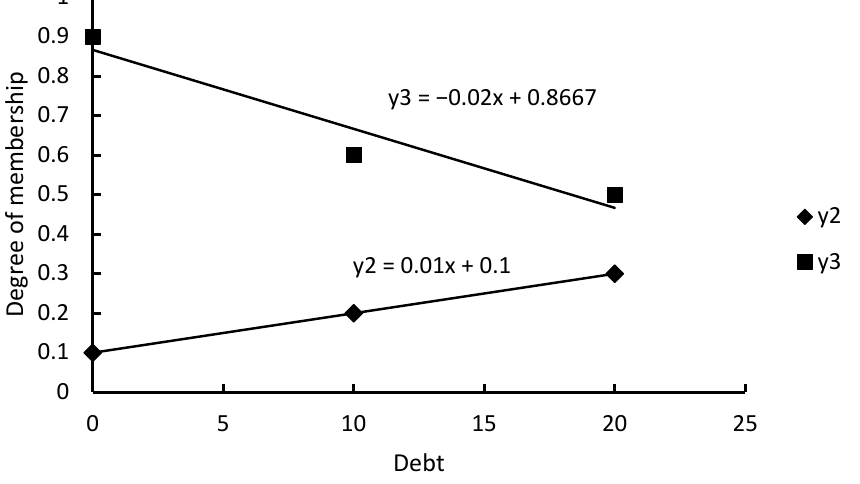
Figure A13. Single factor evaluation for the index of debt (0–20 (inclusive) ten thousand yuan).